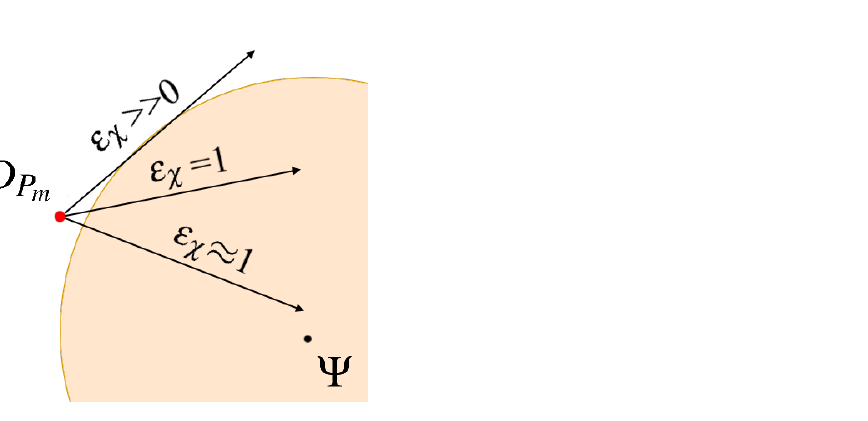
Figure 5. The impact of the coefficient (cid:101) χ on the motion direction of the node D P